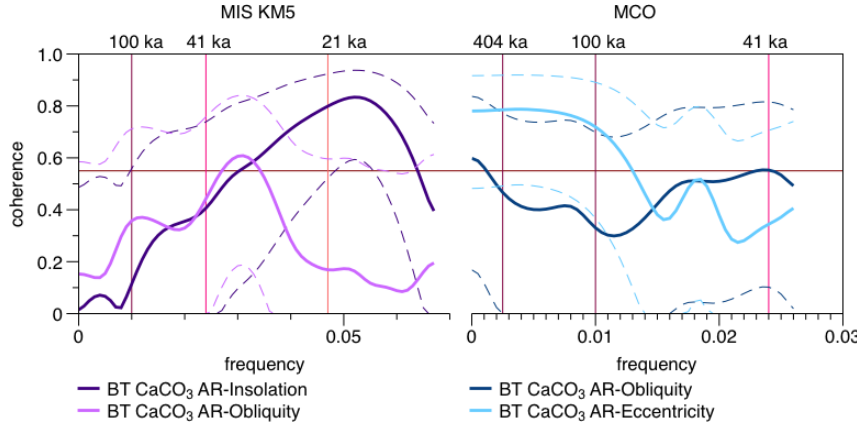
Figure 12. Coherence diagram BT cross correlation (Paillard et al., 1996) between the CaCO 3 AR and the orbital parameters (Laskar et al., 2004). The dashed curves show the 90% confidence intervals. The horizontal red line corresponds to the non-zero coherence at a significance level of 90%. The vertical pink lines correspond to the orbital periodicities (eccentricity at 404 and 100ka, obliquity at 54 and 41ka, and precession at 21ka).